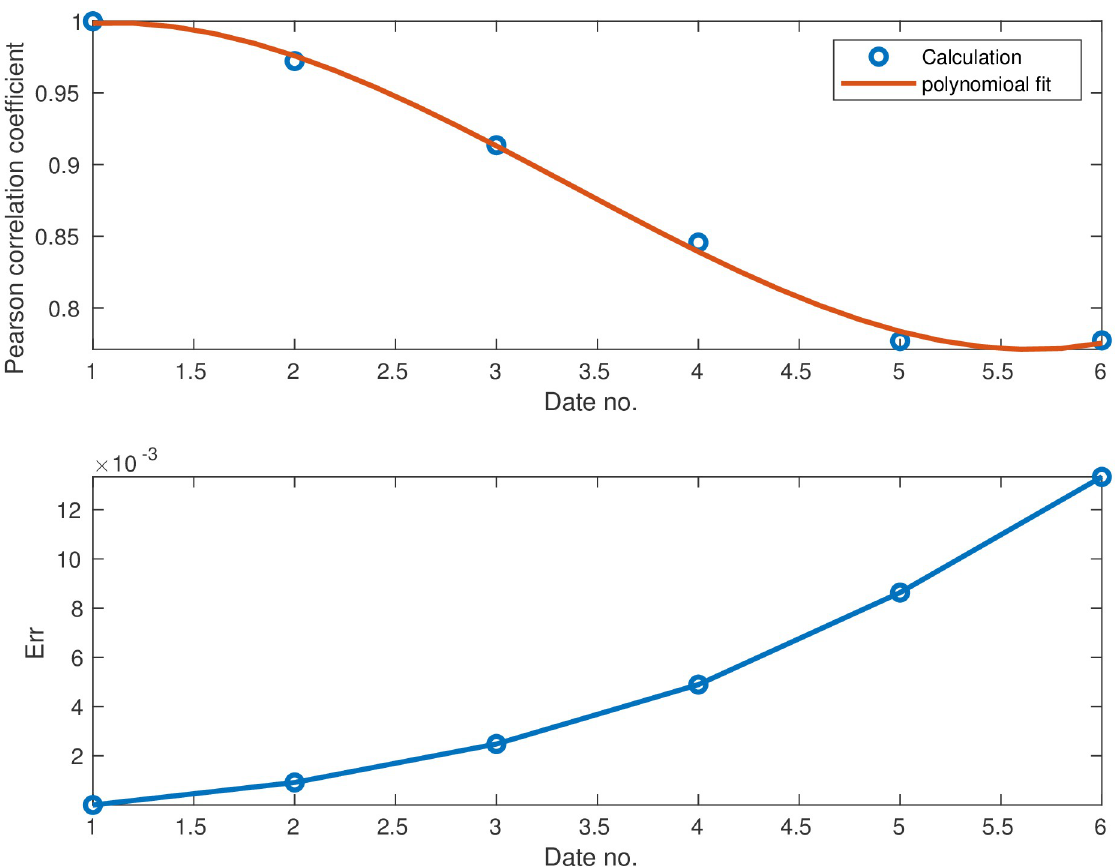
Fig 5. (a) Pearson correlation coefficient between simulation and observation from Eq (3) vs time. A high value of correlation coefficient means good agreement. By definition of the initial conditions, the correlation starts from the maximum value, 1. It then monotonously decays with time. (b) Estimated root-mean-square error Err as defined in Eq (4). The error starts from zero and increases with time.